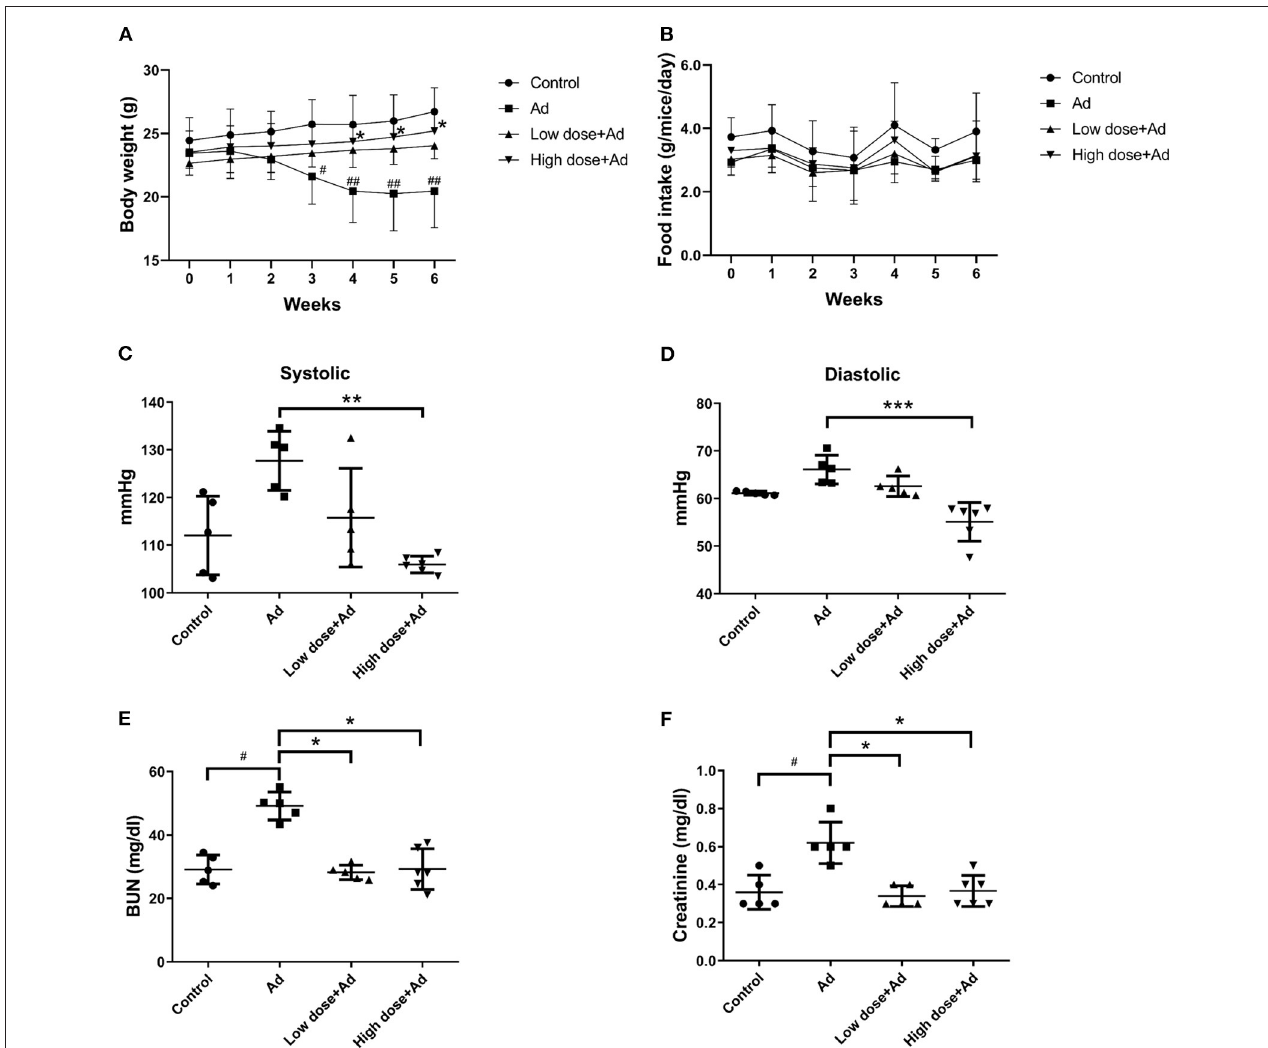
FIGURE 2 | Physical properties and biochemical analyses of mice with adenine (Ad)-induced chronic kidney disease (CKD) after 6 weeks of probiotic treatment. (A) body weight measurement, (B) food intake measurement, (C,D) systolic and diastolic blood pressure measurement, (E) serum blood urea nitrogen (BUN) levels, (F) serum creatinine levels. Mice without any treatments were used as experimental controls. The graphs represent the mean ± SD obtained from five to six mice per group. Statistical analysis was performed by Kruskal–Wallis test. # , * P < 0.05; ## , ** P < 0.01; *** P < 0.001. Asterisk means the significant difference between Ad and high dose + Ad group, or Ad and low dose + Ad group; pound means a significant difference between control and Ad